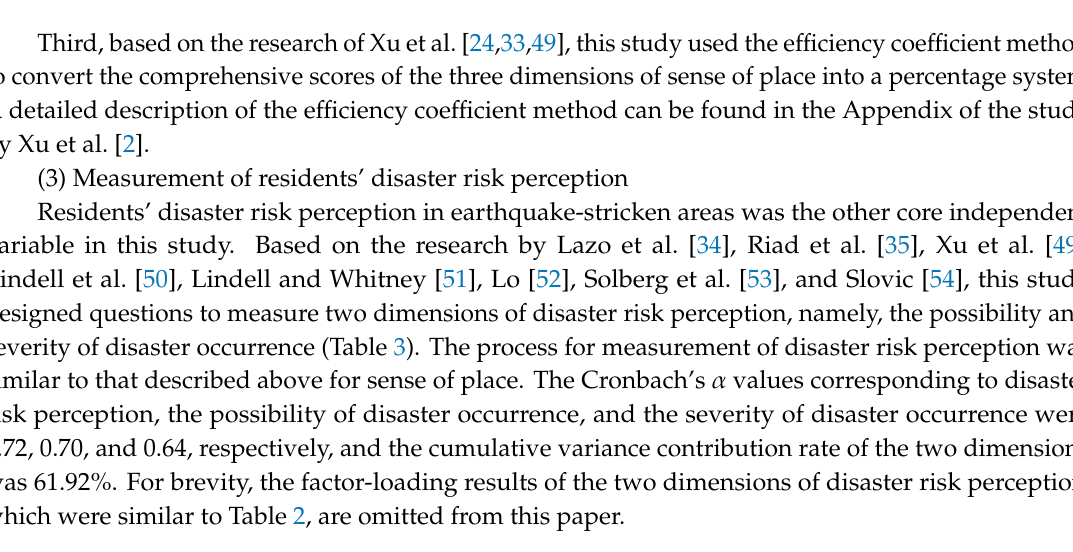
Table 3. Earthquake disaster risk perception